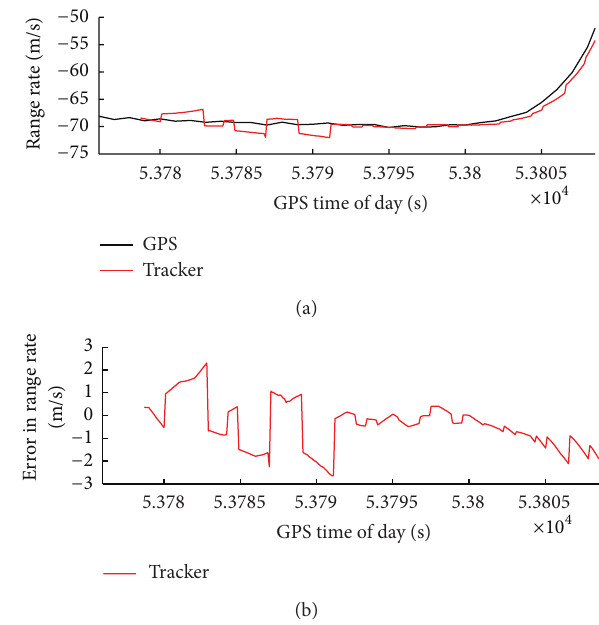
Figure 13: Intruder range rate (GPS and tracker) and relative estimation error (tracker with respect to GPS) as a function of GPS time in the considered